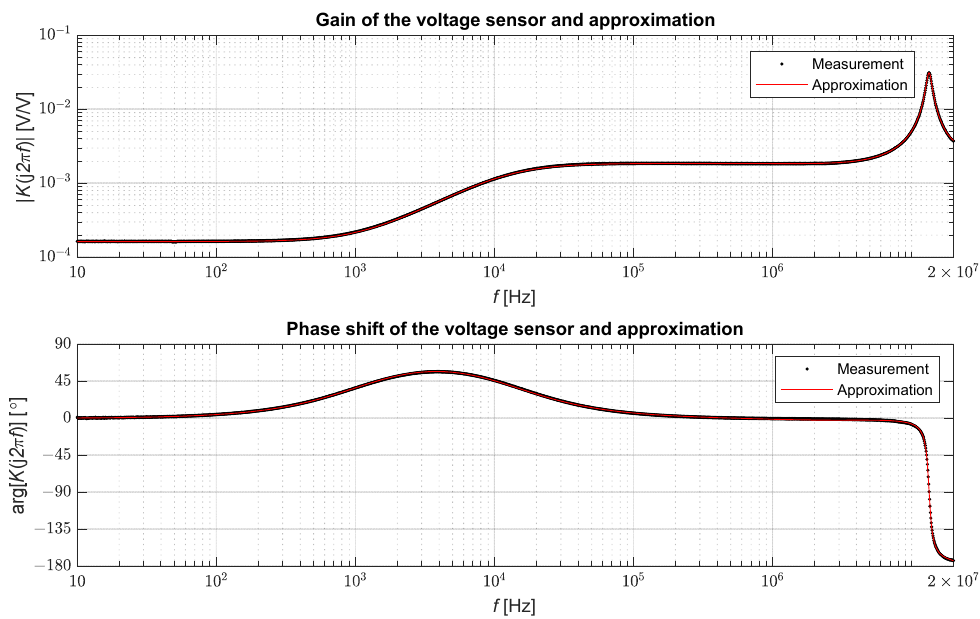
Figure 7. Measurement results of the transmittance of the medium voltage sensor.